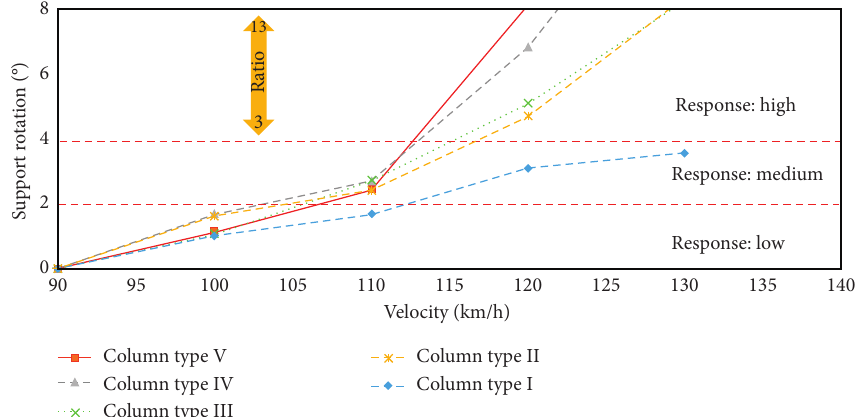
Figure 10: Support rotation degree of the bridge column depending on impact